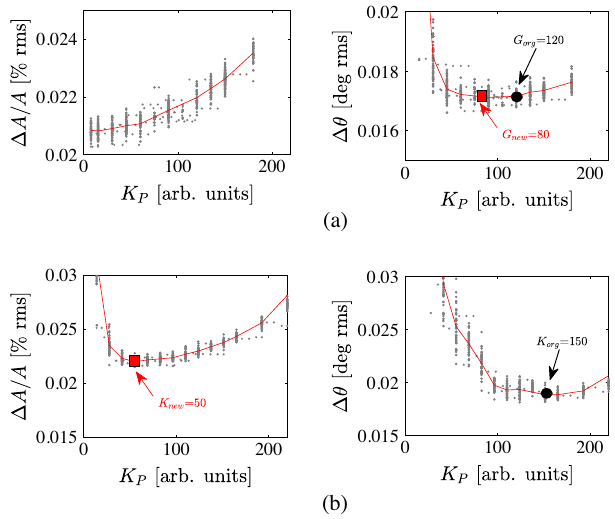
FIG. 9. Gain-scanning result for (a) ML1, (b) ML2. The subplots on the left and right indicate the amplitude and phase stabilities, respectively. Before 2014, G mined as the optimal gains based on the phase performance. From ¼ 0 Hz, and 2015 to the present, G offset operational gain to reduce the rf